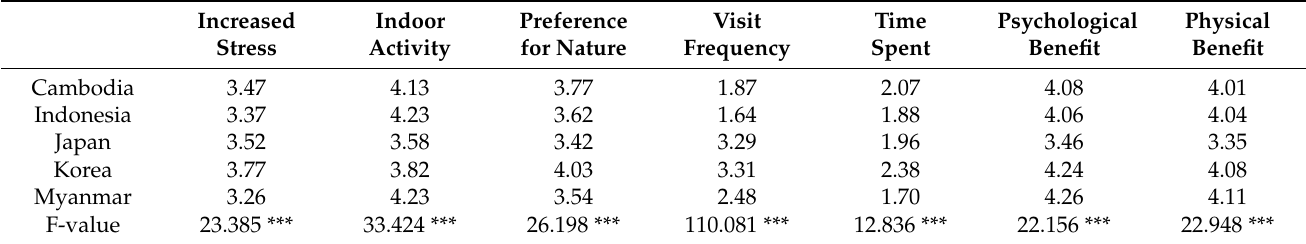
Table 4. ANOVA of interview results and behavior (mean